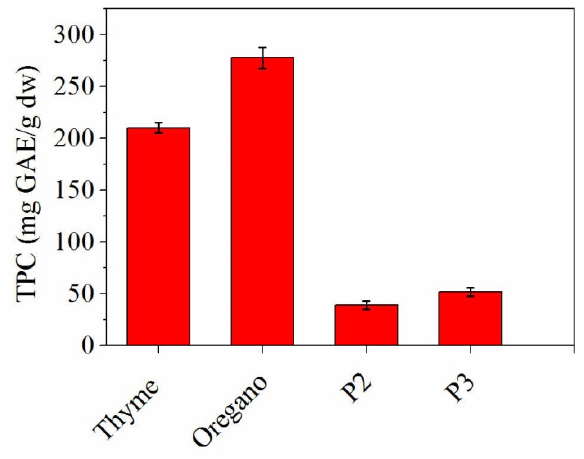
Figure 3. Total phenolic content for thyme essential oil, oregano essential oil and nanofibres based on collagen and essential oils.